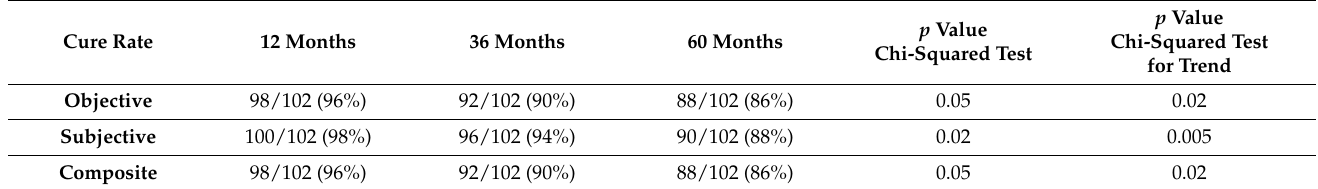
Table 4. Cure rates at the 12-months 36-months and 60-months follow-up visit.